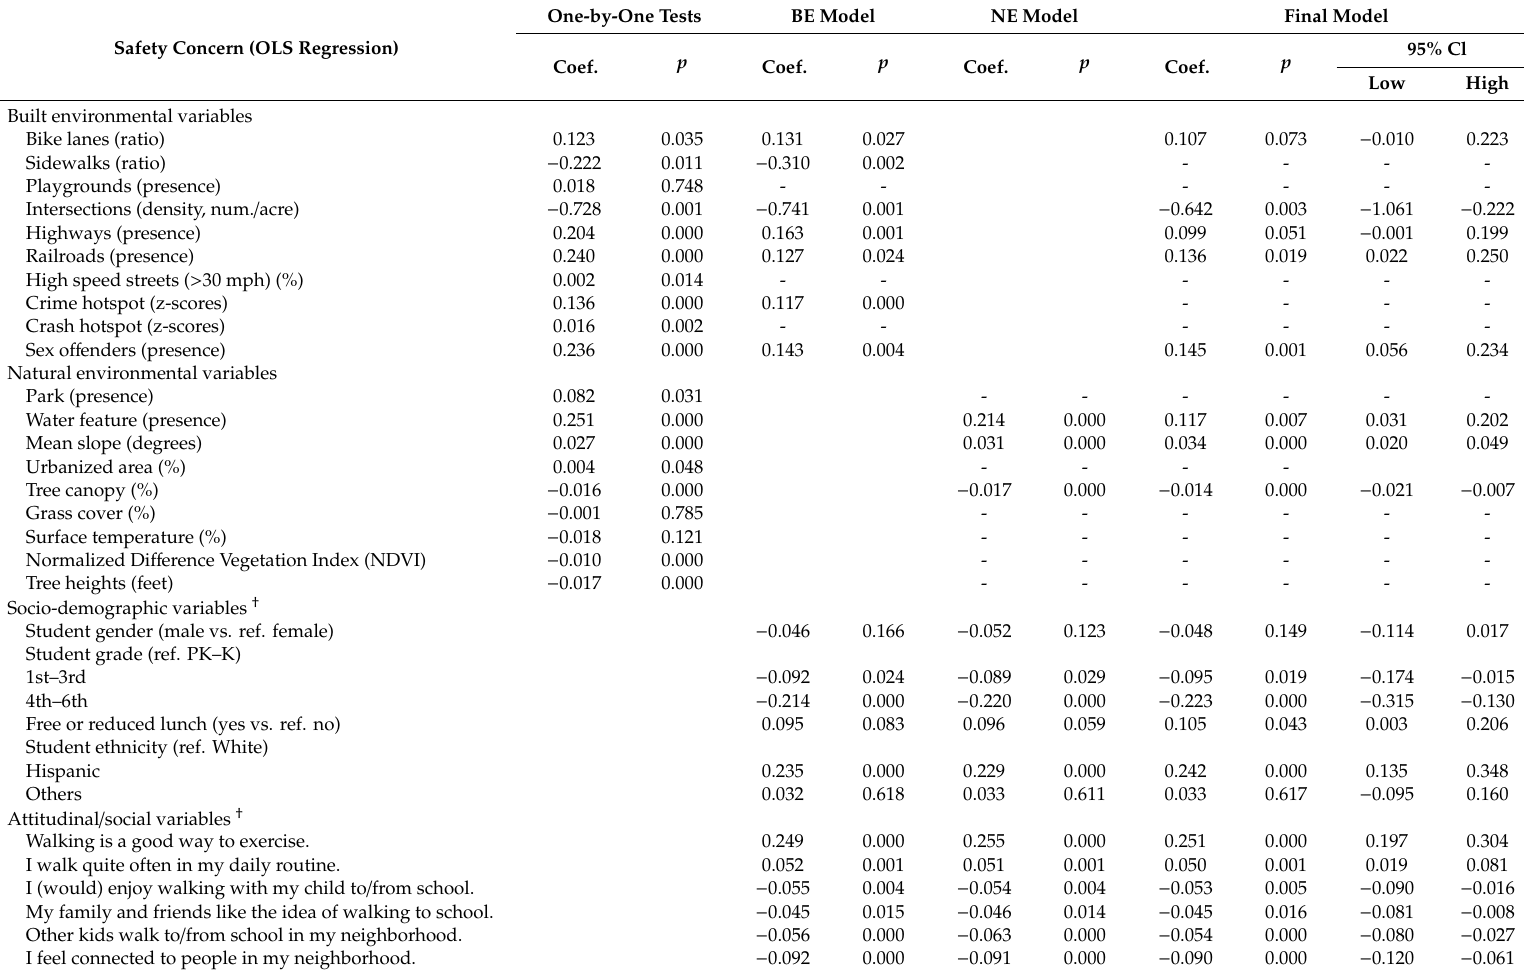
Table 2. Built and natural environmental correlates of parental safety concerns ( n =